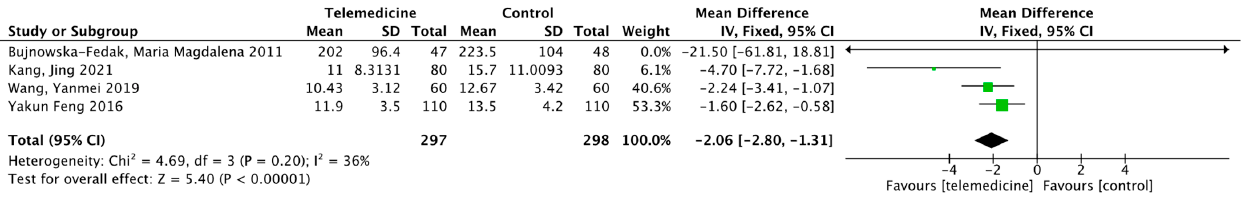
Figure 7. Mean difference in the changes in PBG levels for telemedicine and usual care interventions.